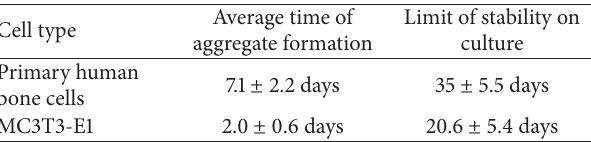
Table 3: Time of formation and stability of spheroids produced with primary human or murine line cells, at an initial density of 20,000 cells ( 𝑛 = 20